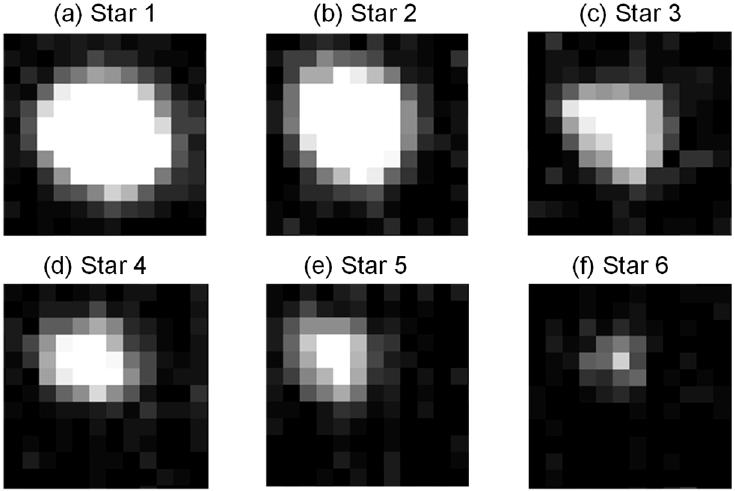
Figure 17. The six kinds of stars with different sizes: ( a ‐ f ) Star 1 to Star 6 corresponded to 1 Mv, 2 Mv, 3 Mv, 4 Mv, 5 Mv, and 6 Mv, respectively.